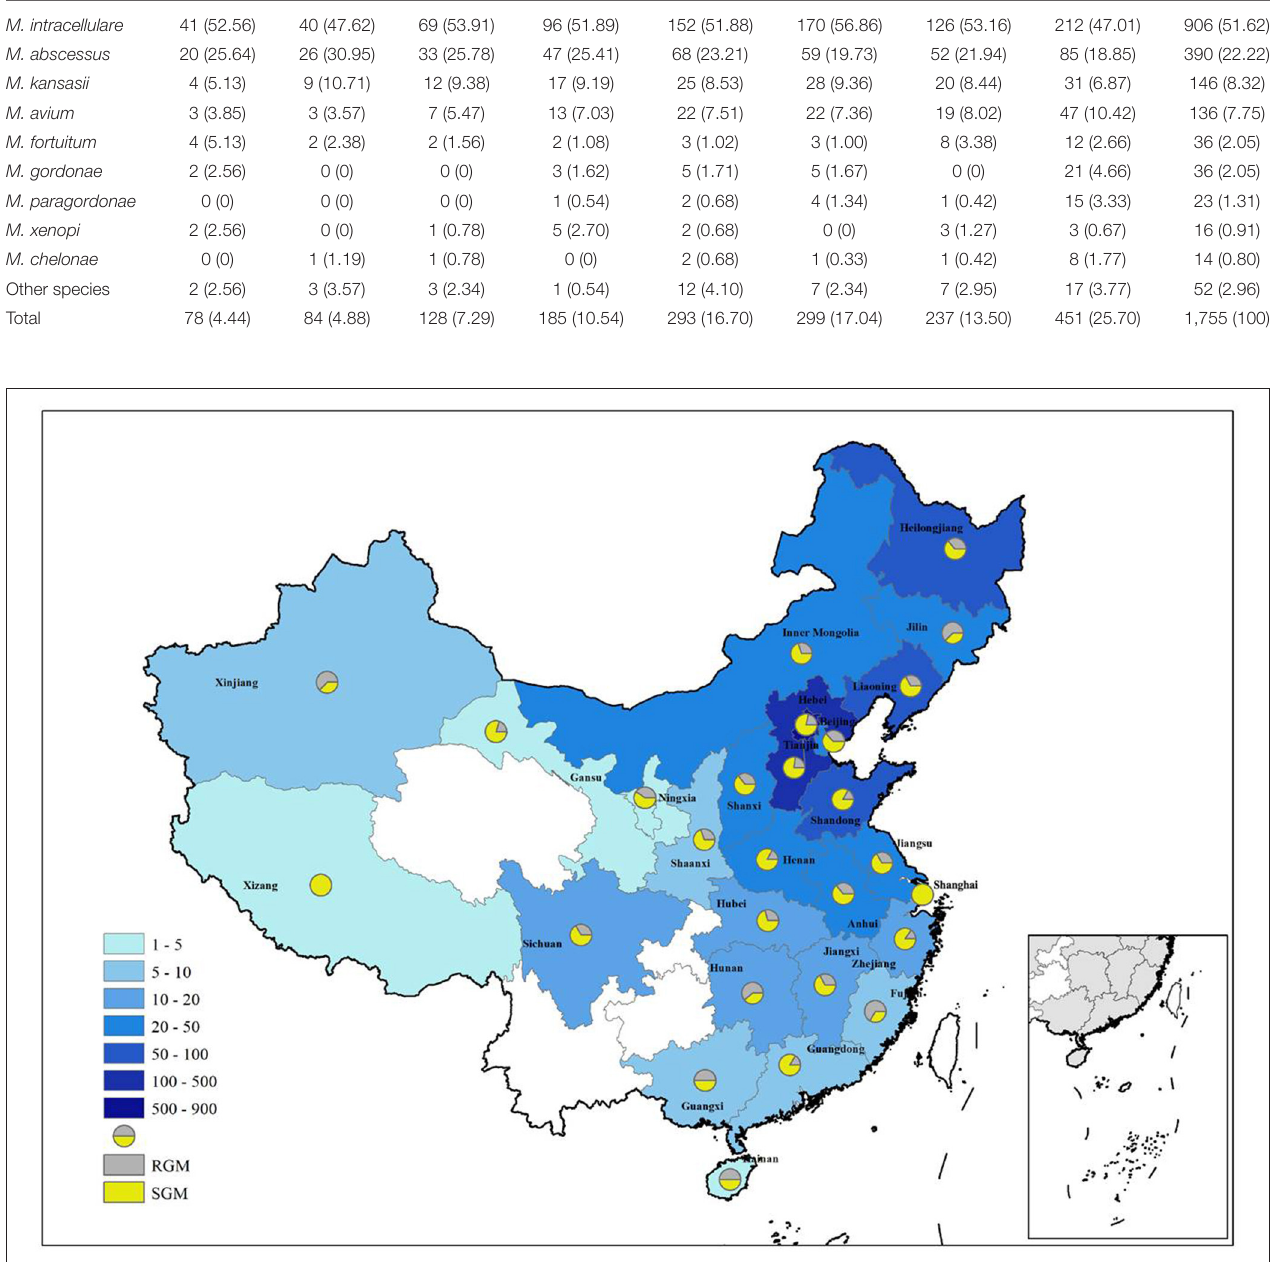
FIGURE 4 | Distribution of NTM in different provinces of China. RGM rapid growing mycobacteria, SGM slow growing mycobacteria.